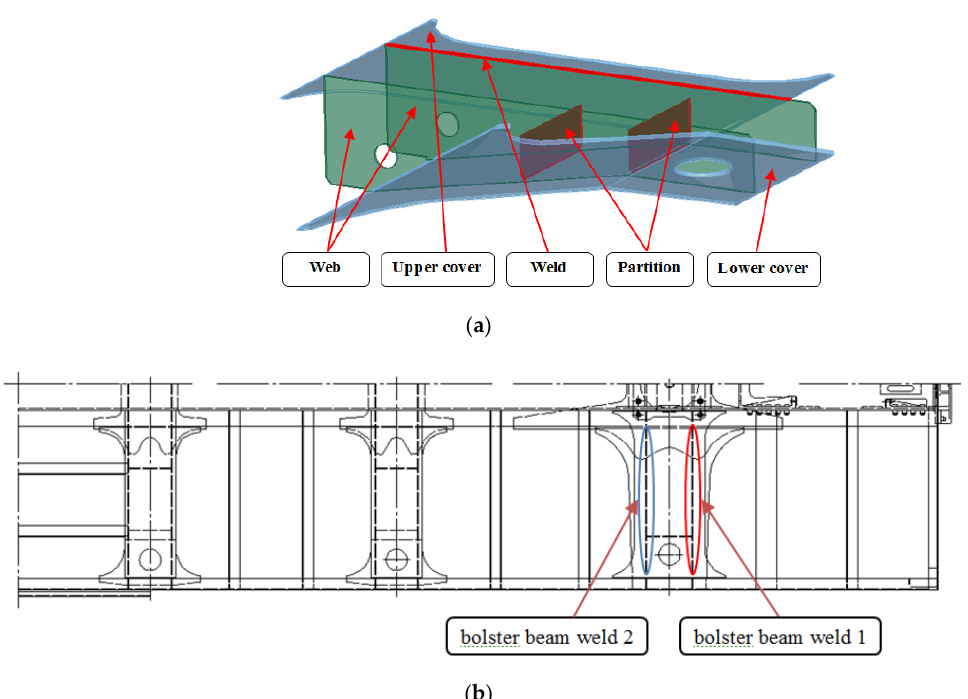
Figure 4. Bolster beam and its weld ( a ) the structure and parts’ name; ( b ) the definition of bolster beam weld.